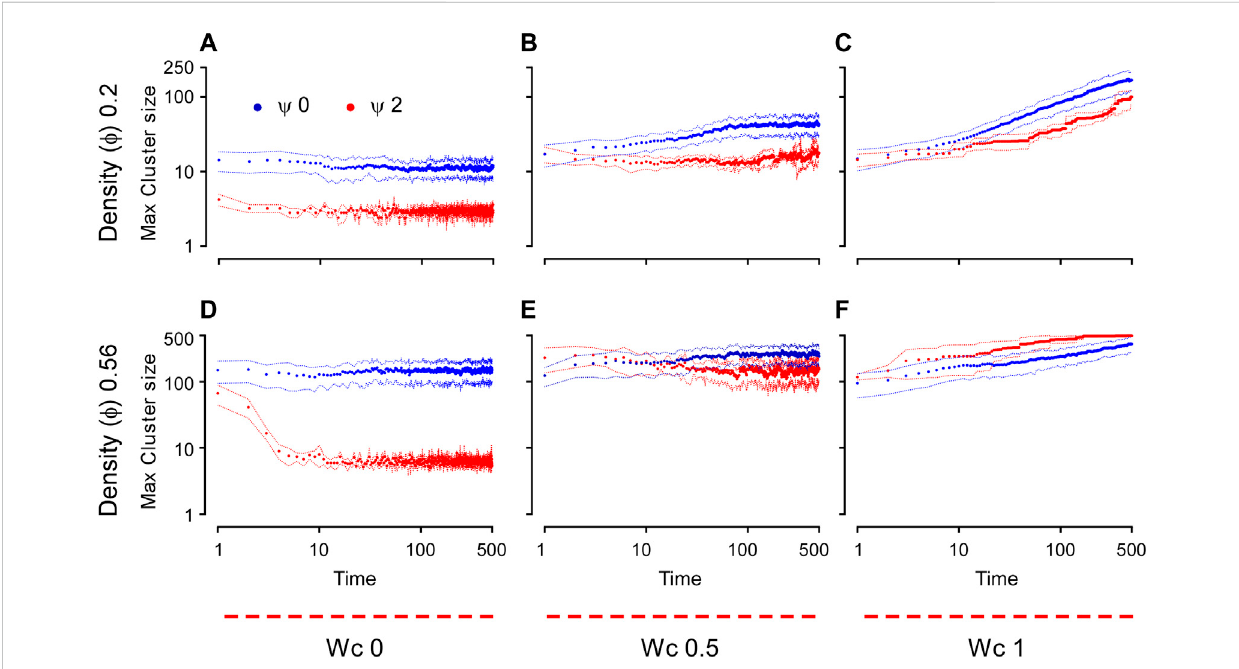
FIGURE 6 Time dynamics of the aggregation of the cell-autonomous system measured by the maximum cluster size. The cluster size is plotted here as a function of time for different cell densities, both conditions include 500 cells in each simulation ( ϕ (cid:1) 0 . 2, (A – C) ; ϕ (cid:1) 0 . 56, (D – F) for different W c (0, 0.5, and1for the fi rst,second,and thirdcolumn,respectively) and fortwodifferentvalues of ψ (0 forthebluecirclesand 2fortheredones).The circlesarean average from 50 different simulations, and the dashed lines represent the range within the standard deviation. All plots are generated using a logarithmic